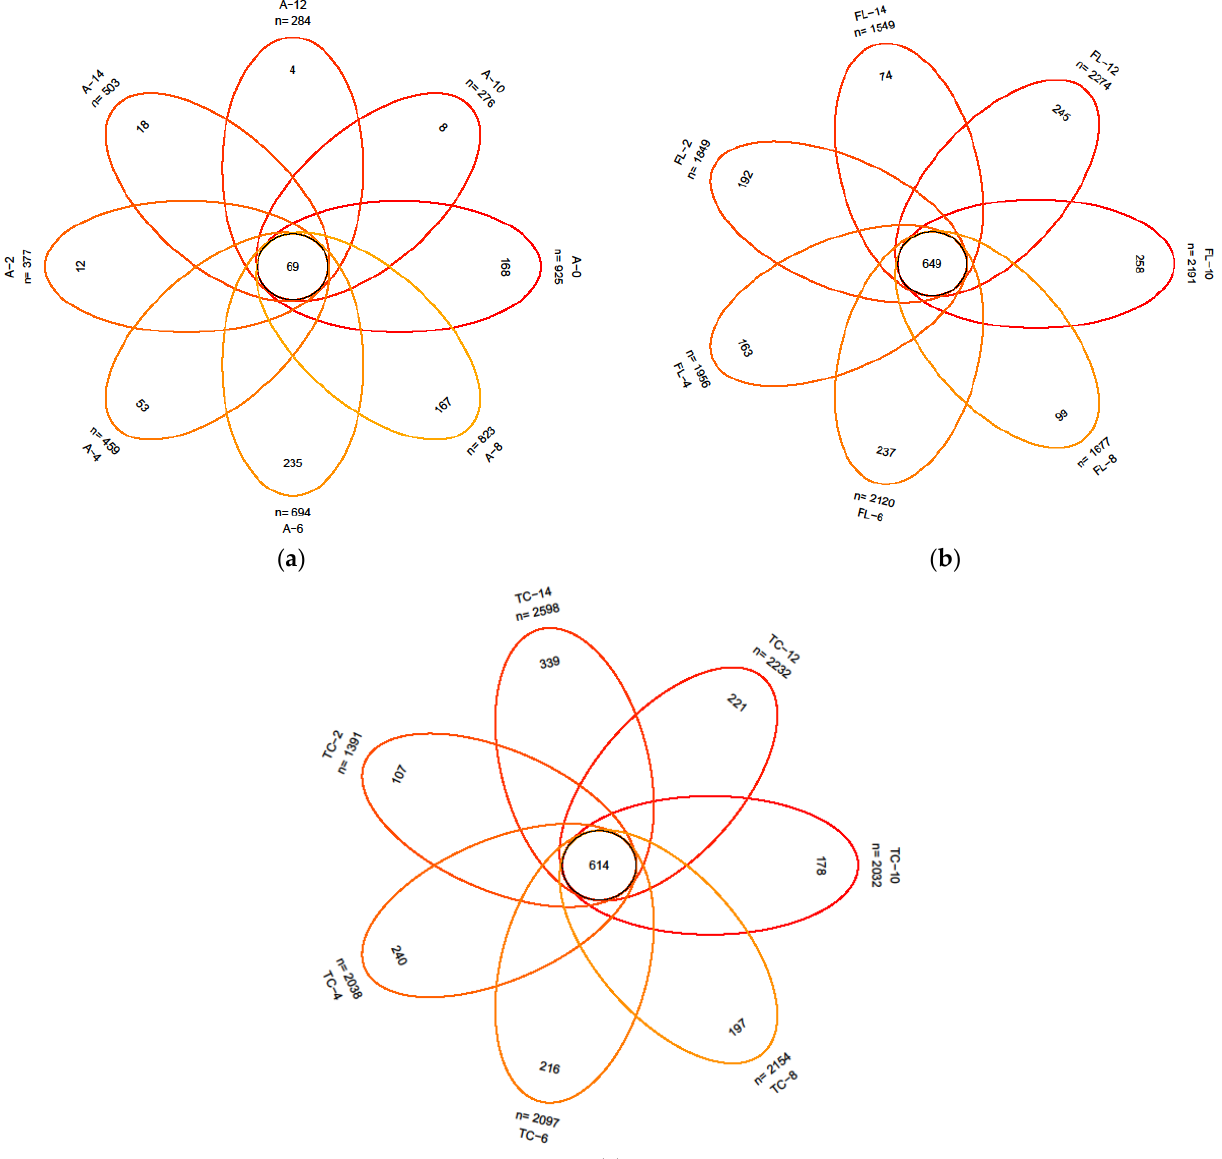
Figure 5. Venn diagrams of air ( a ), foreleg ( b ), and thorax ( c ) microorganisms throughout the cooling process.